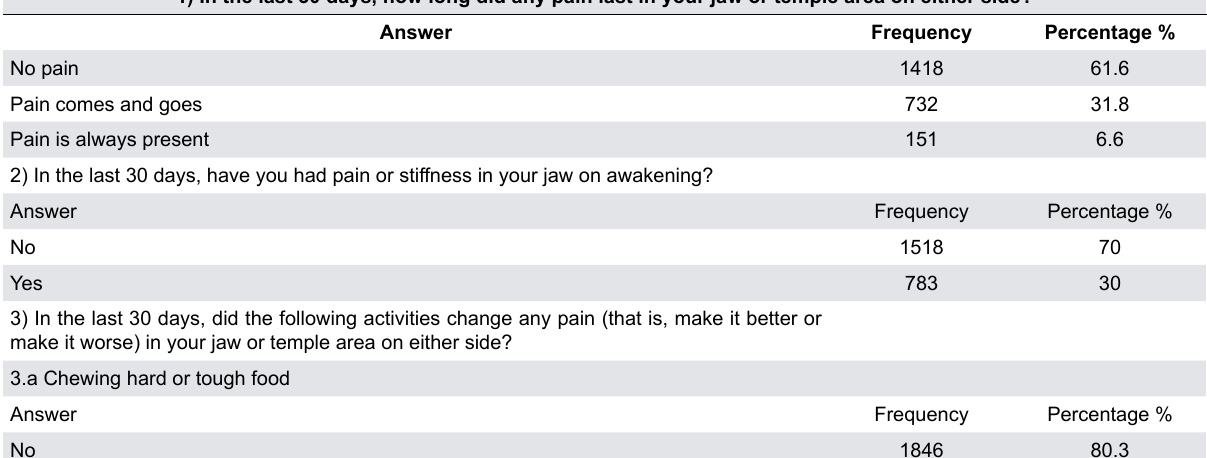
Table 2- Distribution for each question of TMD-Pain Screener